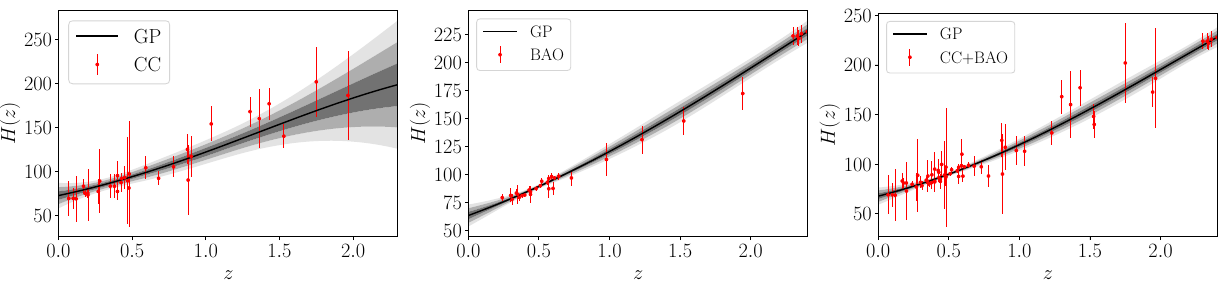
Fig. 1 Plots for H ( z ) reconstructed from CC data (left), BAO data (middle), and combined CC + BAO data (right). The solid black line is the “best fit” and the associated 1 σ , 2 σ and 3 σ confidence regions are shown in lighter shades